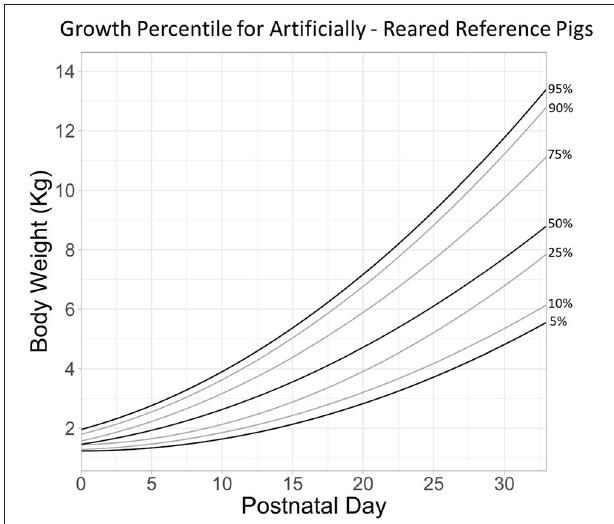
FIGURE 2 | Growth percentile chart for artificially reared reference pigs is plotted as body weight as a function of postnatal day. Lines are growth quantile fits corresponding to 0.05, 0.10, 0.25, 0.50, 0.75, 0.90, and 0.95 quantiles.